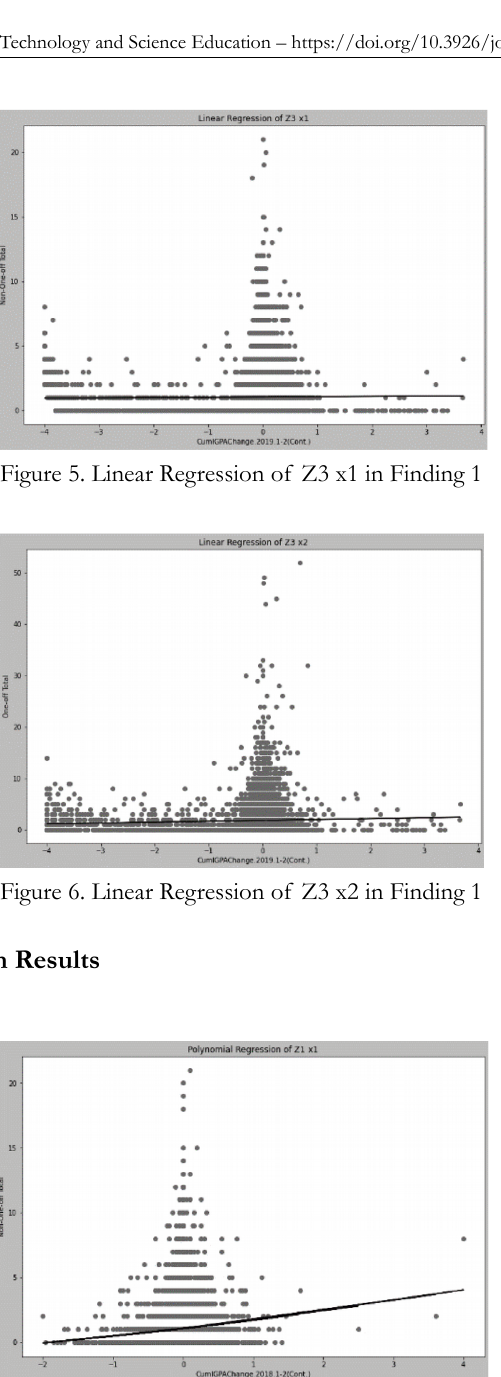
Figure 7. Polynomial Regression of Z1 x1 in Finding 1